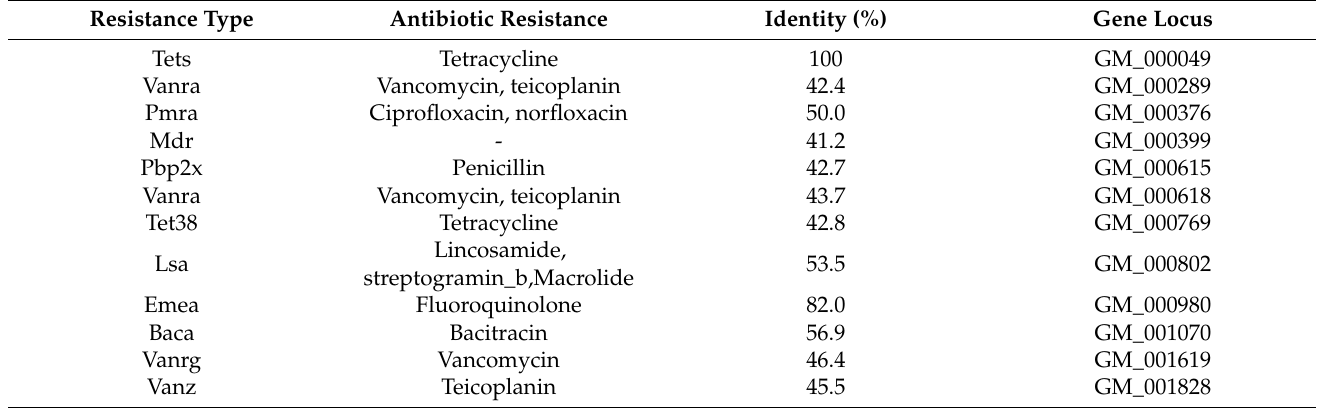
Table 2. Putative antibiotic resistance genes identified in the genome of Lactococcus garvieae FUA009. Resistance